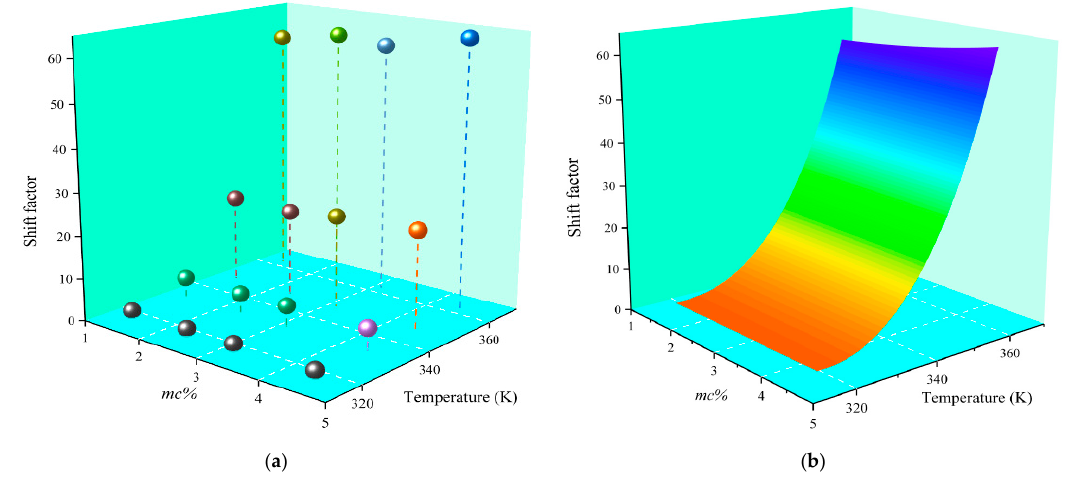
Figure 6. The variation law of shift factor. ( a ) The scatter plot of test temperature, mc% and shift factor; ( b ) The fitting surface of the shift factor.